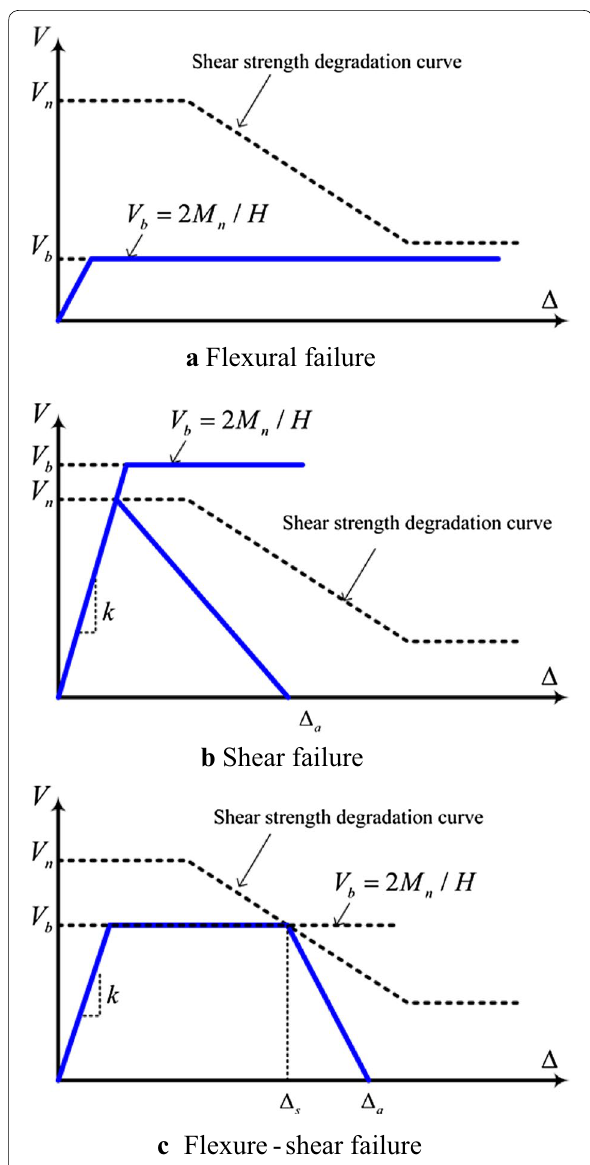
Fig. 18 Lateral load‑deformation relationship of